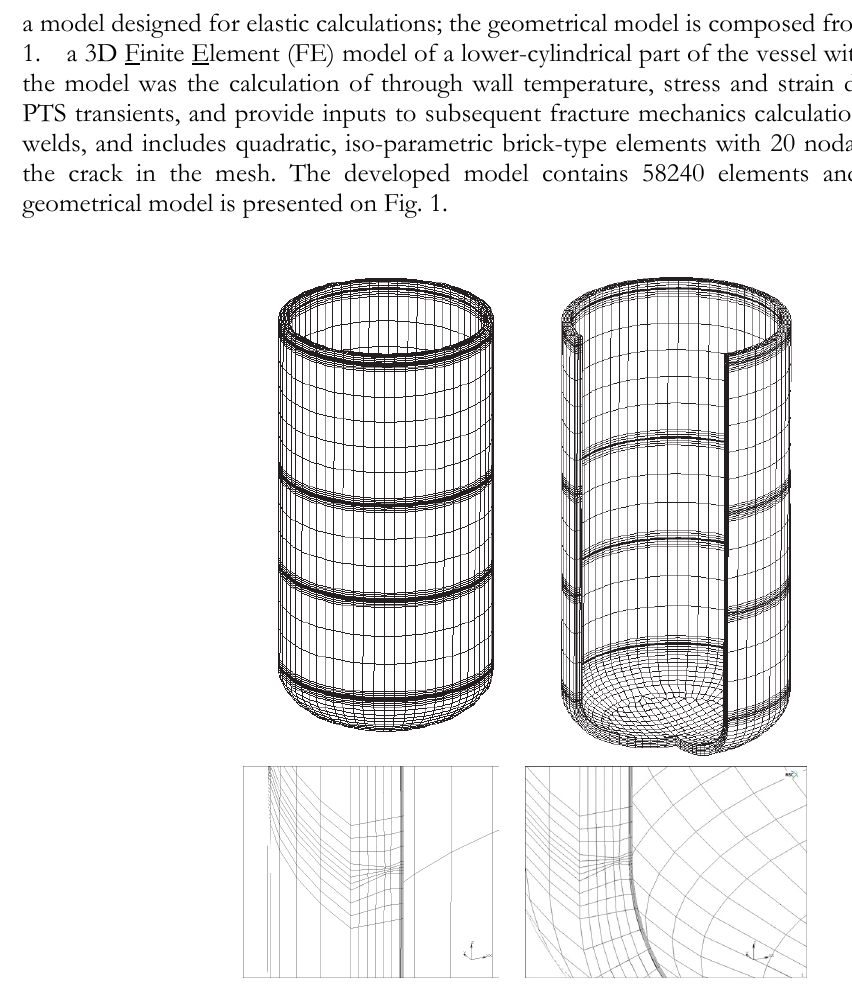
Figure 1: 3D Finite Element model of a lower cylindrical part, bottom and welds of a VVER-440 RPV. 2.